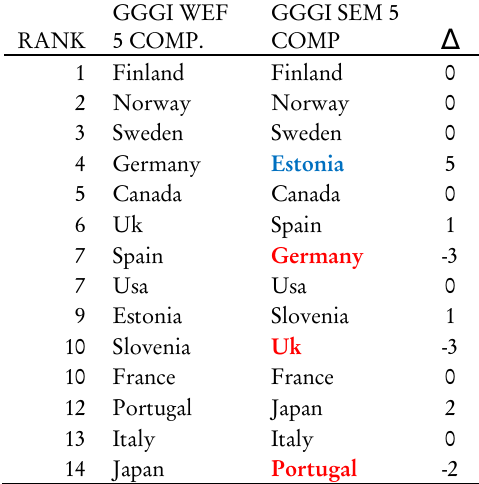
Comparison between GGGI with 5 components and traditional WEF weights and proposed GGGI 5 components based on SEM loadings